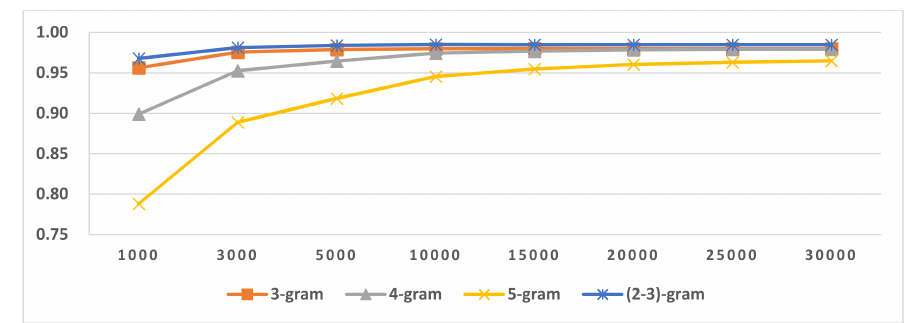
Figure 22. LI in Indo-European/Germanic in